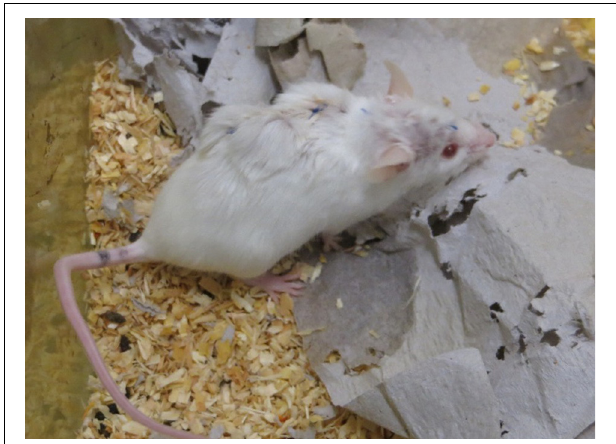
FIGURE 3 | Freely moving mouse with implanted stimulator, 1 / 2 h after operation.